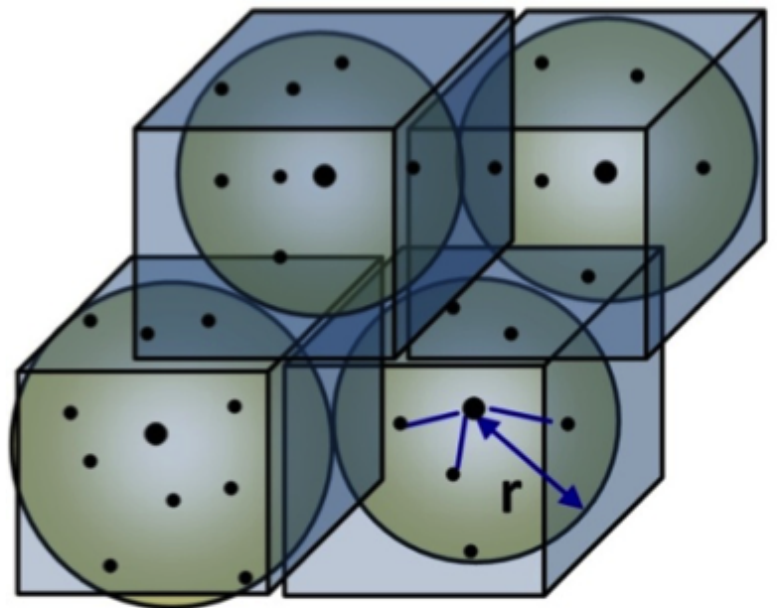
Figure 8. A number of points is grouped together to form cubical voxels of a maximum size 2 × r where r is the radius and the actual voxel sizes vary according to the maximum and minimum values of the neighboring points found along each